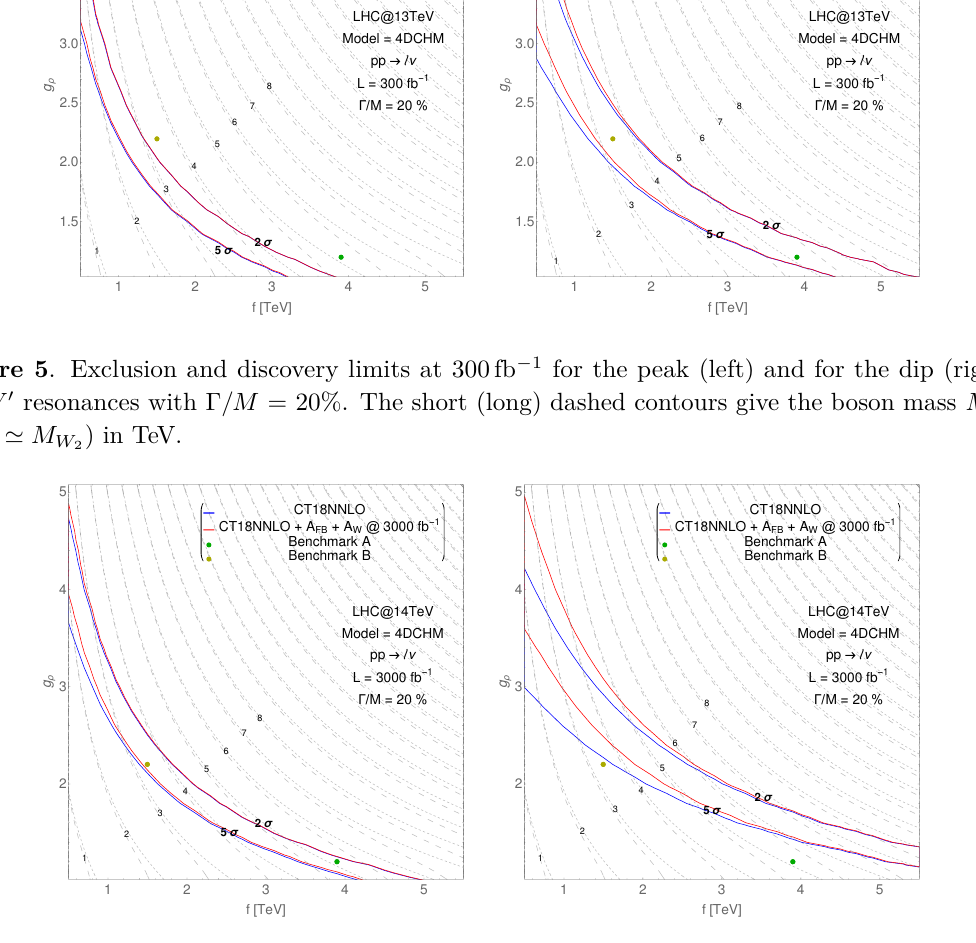
Figure 6 . Exclusion and discovery limits at 3000 fb − 1 for the peak (left) and for the dip (right) for W 0 resonances with Γ /M = 20%. The short (long) dashed contours give the boson mass M Z ( M Z ’ M W ) in 3 2